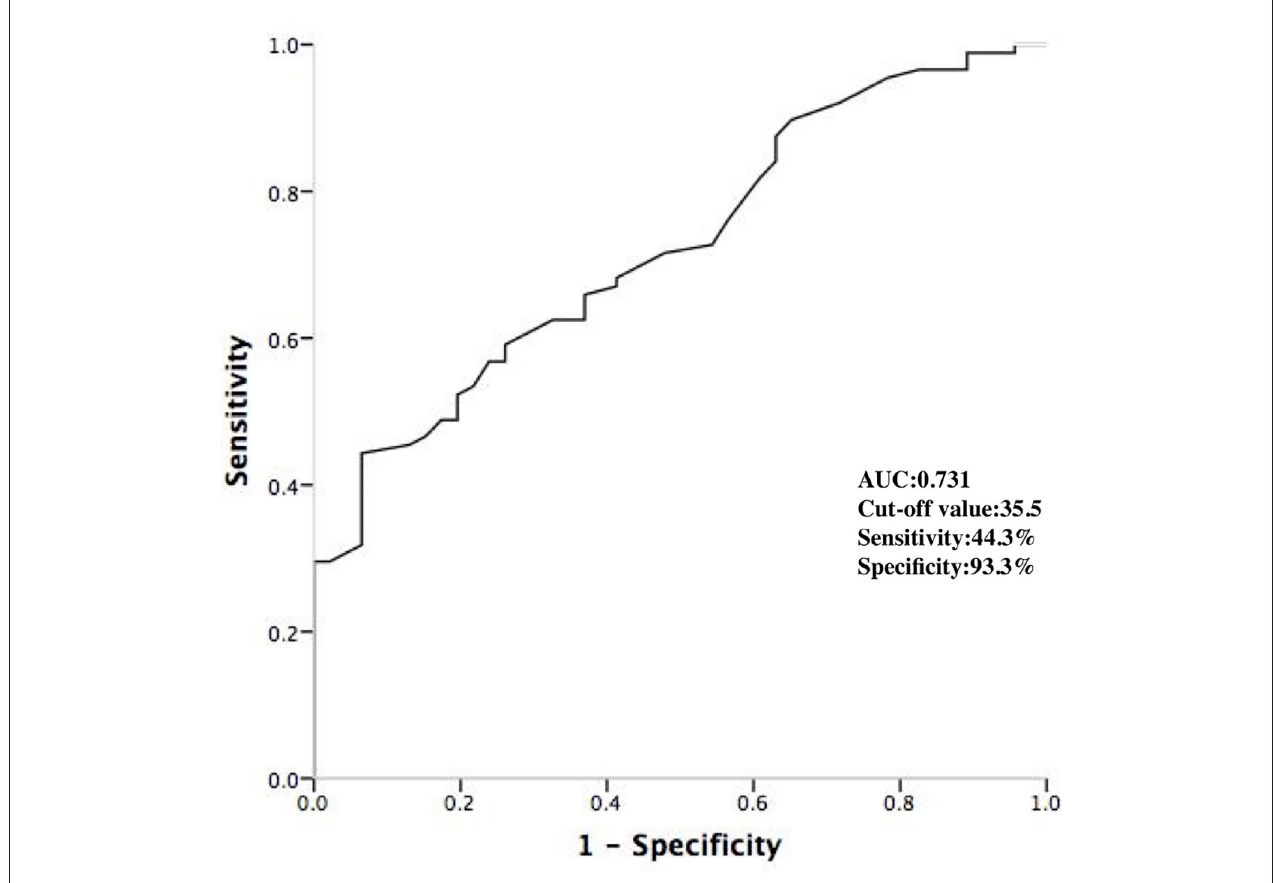
FIGURE 5 | ROC curve analyzing the age to predict the DPPs. DPP, discrete pre-potential; AUC, area under